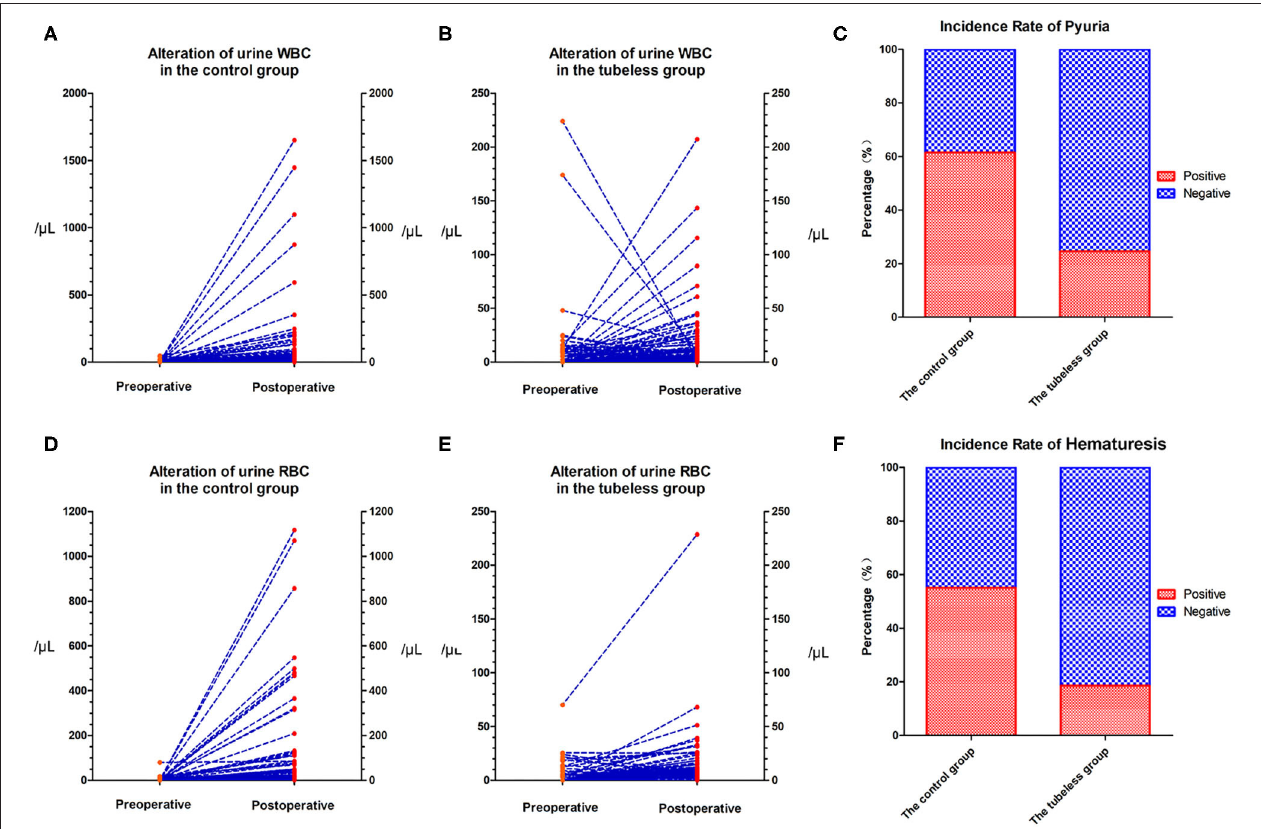
FIGURE 2 | Alteration in urine RBC and WBC levels. (A) Alteration of urine WBC level in the control group; (B) alteration of urine WBC level in the tubeless group; (C) incidence rate of pyuria; (D) alteration of urine RBC level in the control group; (E) alteration of urine RBC level in the tubeless group; (F) incidence rate of hematuresis. RBC, red blood cell; WBC, white blood cell.